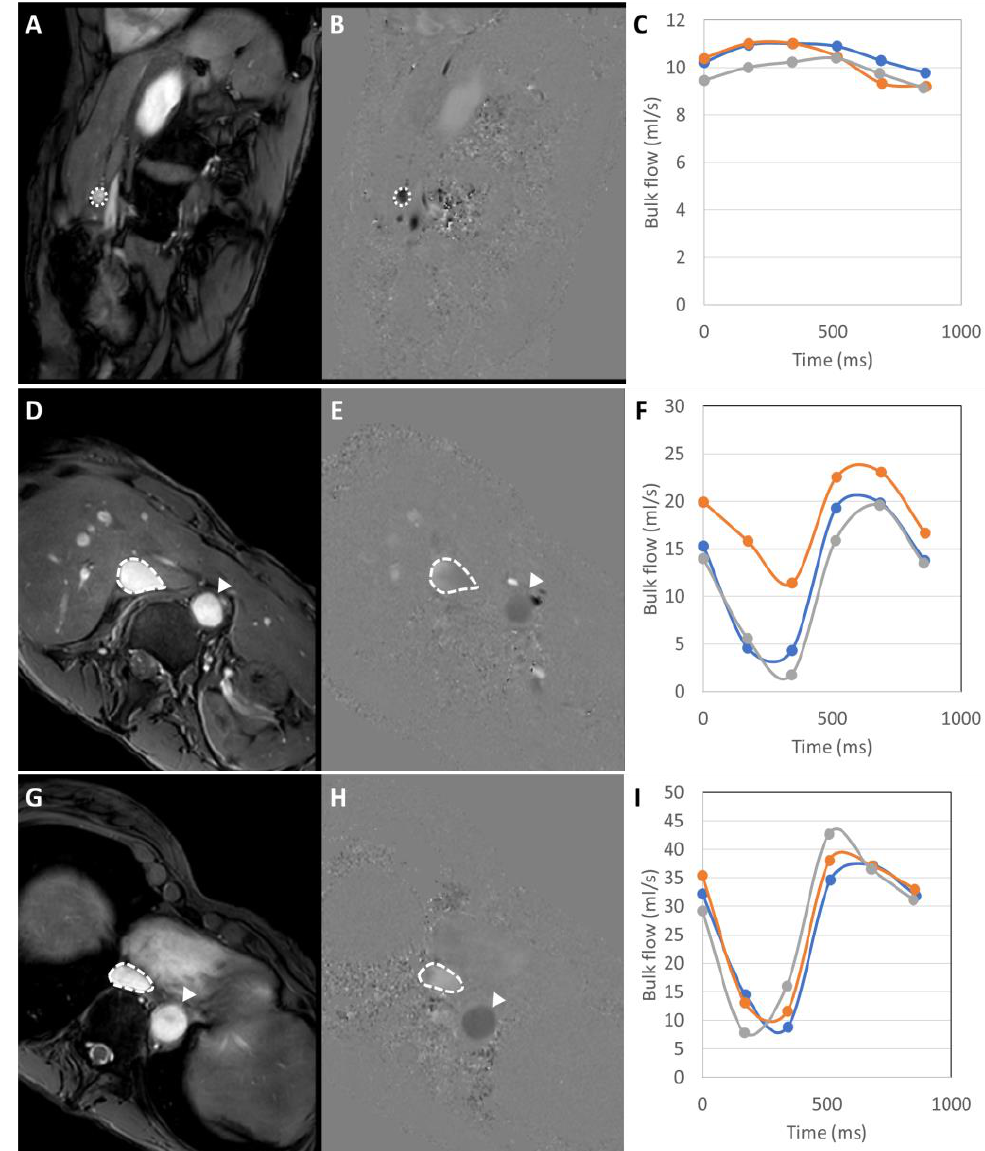
Figure 5. Two-dimensional phase-contrast measurements of bulk vessel flow in the portal vein ( A – C ), infrahepatic inferior vena cava ( D – F ) and suprahepatic inferior vena cava ( G – I ). Magnitude anatomical images ( A , D , G ) were used for vessel segmentation (dashed regions of interest), with segmentation of the portal vein ( A ), infrahepatic inferior vena cava ( D ) and suprahepatic inferior vena cava ( G ). These were transcribed onto matched velocity maps ( B , E , H ) and manually adjusted for seven-phases through the cardiac cycle. Measurements were performed in triplicate and corresponding bulk vessel flow across the cardiac cycle was averaged to estimate bulk flow in ml / min for the ( C ) portal vein (612 mL / min in this example), ( F ) infrahepatic inferior vena cava (858 mL / min in this example) and ( I ) suprahepatic inferior vena cava (1638 mL / min in this example). Total liver blood flow was estimated by subtracting infrahepatic from suprahepatic inferior vena cava flow (780 mL / min in this example). Bulk flow measurements were normalised to liver volume estimated from segmentation of the liver on anatomical imaging.